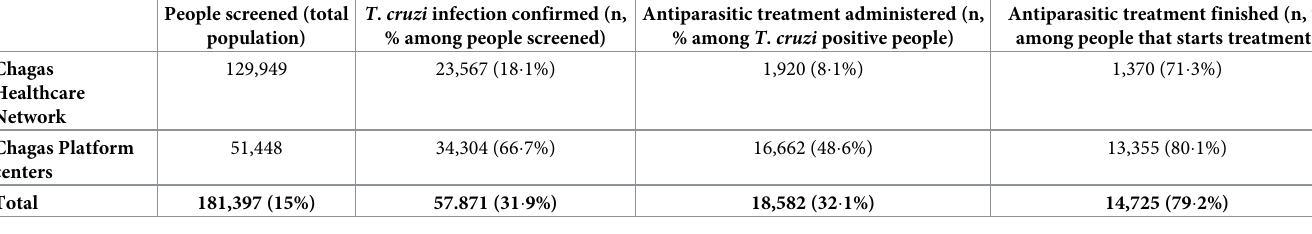
Table 2. Chagas Platform and Chagas Healthcare Network coverage (2010–2018). People screened (total